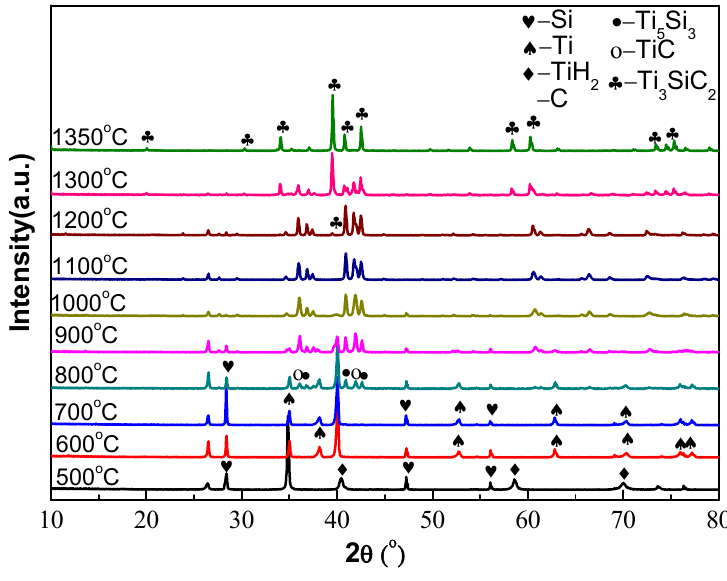
Figure 2. XRD patterns of the compacts under different final sintering temperatures.